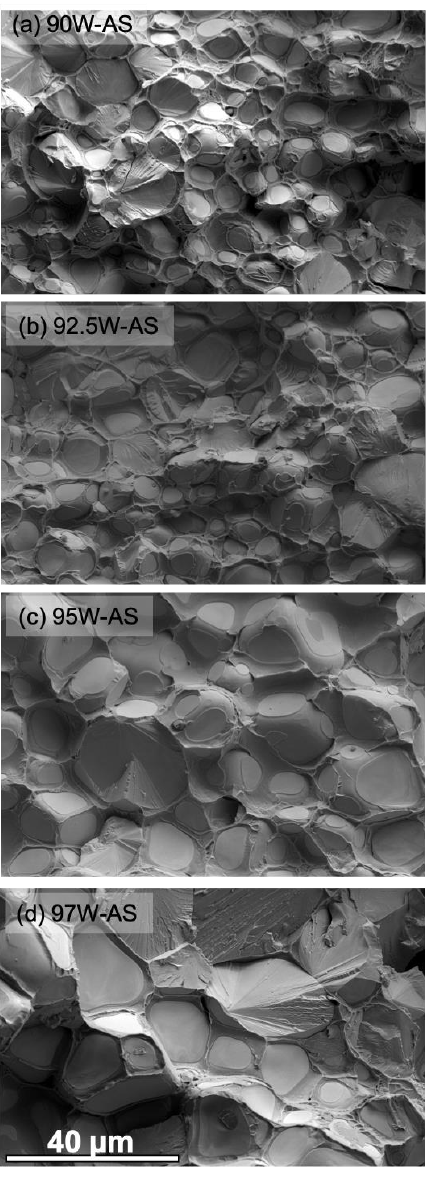
Figure 7. SEM micrographs probed on the fractured face for tensile specimens for ( a – d ) AS and ( e – h ) AN 90, 92.5, 95, and 97W WHAs,